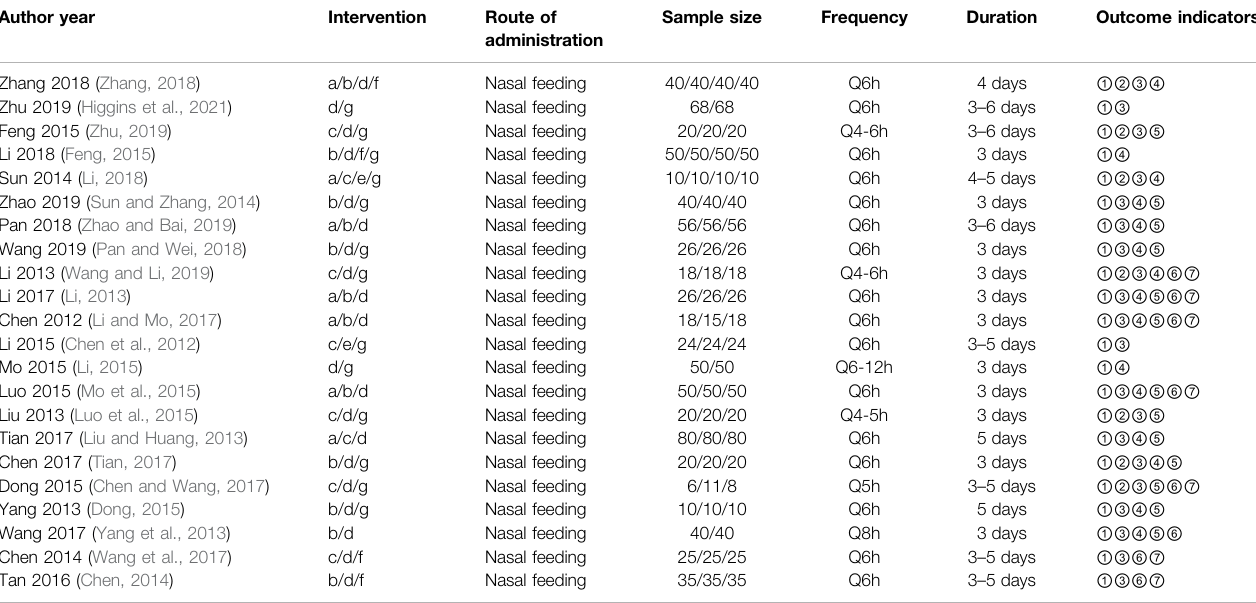
TABLE 1 | Baseline characteristics of the included